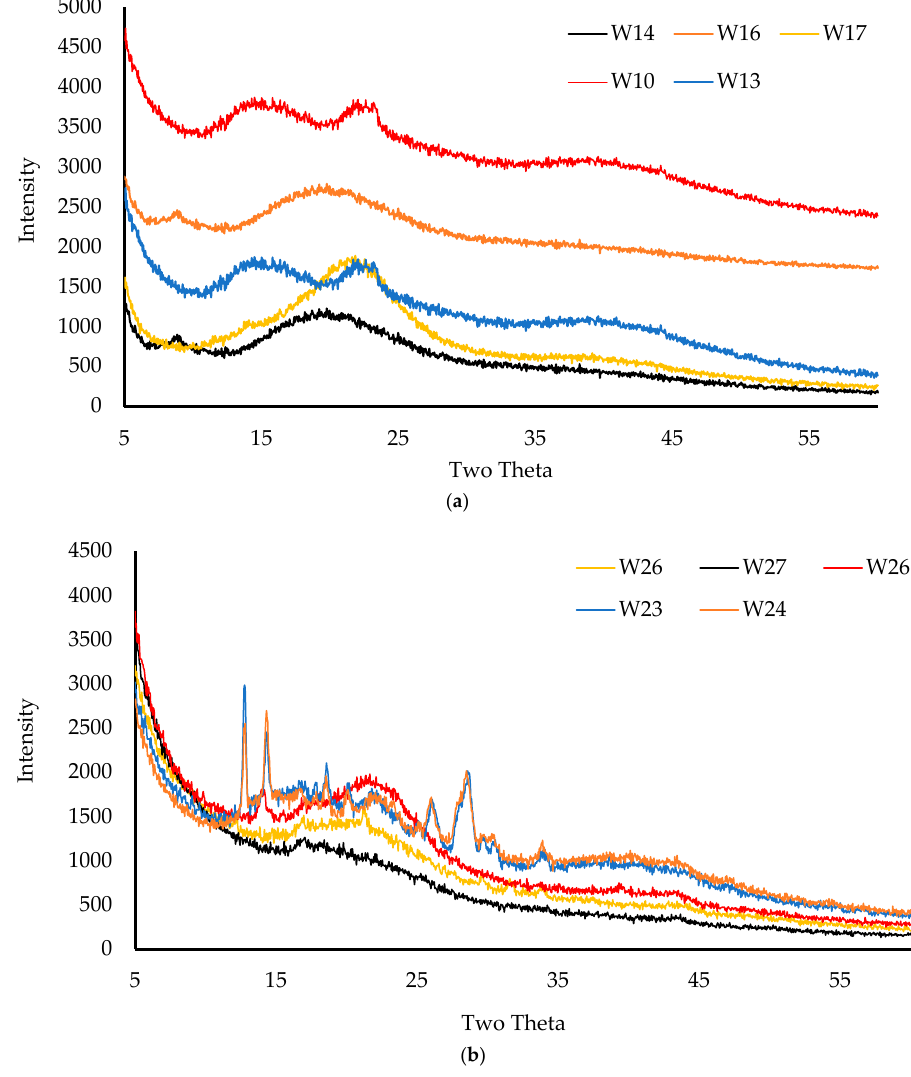
Figure 7. XRD transmission diffractograms of the BLK ( a ) and DL wafers ( b ). The diffractogram in Figure 7b confirms the general amorphous nature of the poly- meric matrix of the DL wafers, with reduced intensity of the crystalline peaks related to MTz from a 2 θ of 12° to 35°. This suggests that most of the drug was molecularly dispersed within the polymeric wafer matrix, with the excess that crystallized on the pore walls (SEM results) detected as crystalline peaks. The W25 wafer had a broad peak at 2 θ values of 20° and 25°, and this was due to the presence of PEG. Amorphous formulations provide better hydration and swelling, which also impacts the rate of drug release.